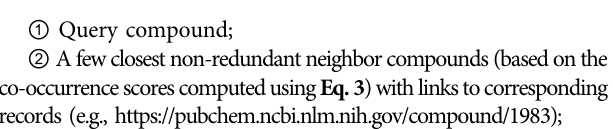
Frontiers in Research Metrics and Analytics |